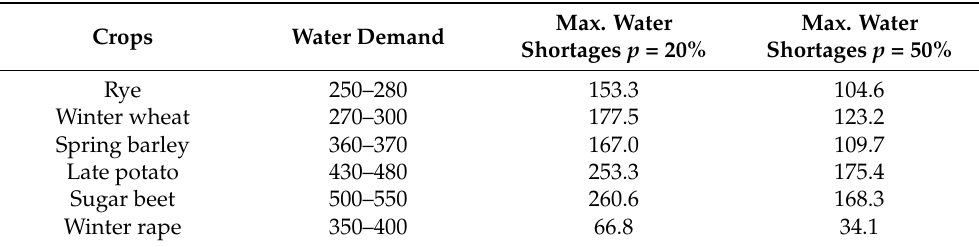
Table 1. Water needs and maximum water shortages (with a probability of 20% and 50%) in the main crops in Braniewo poviat [mm].